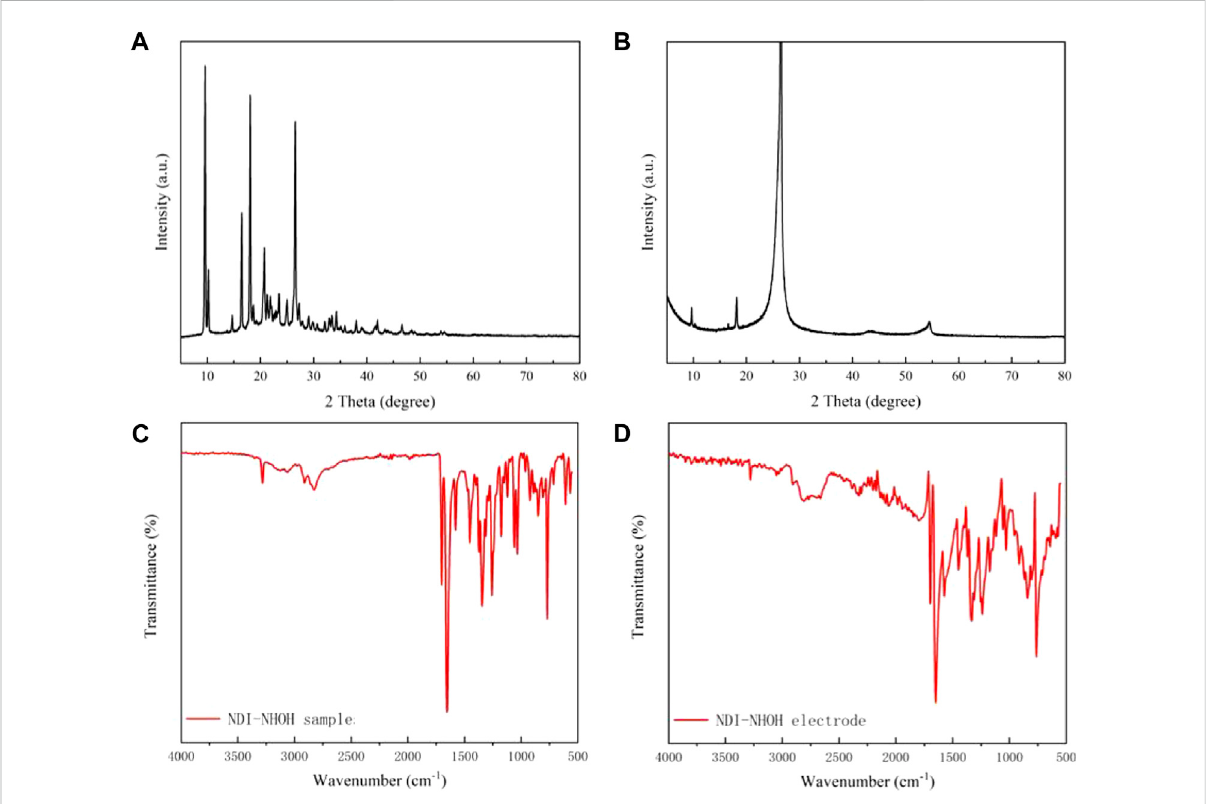
FIGURE 3 XRD curves of (A) NDI-NHOH sample, and (B) NDI-NHOH based electrode; IR curves of (C) NDI-NHOH sample, and (D) NDI-NHOH based